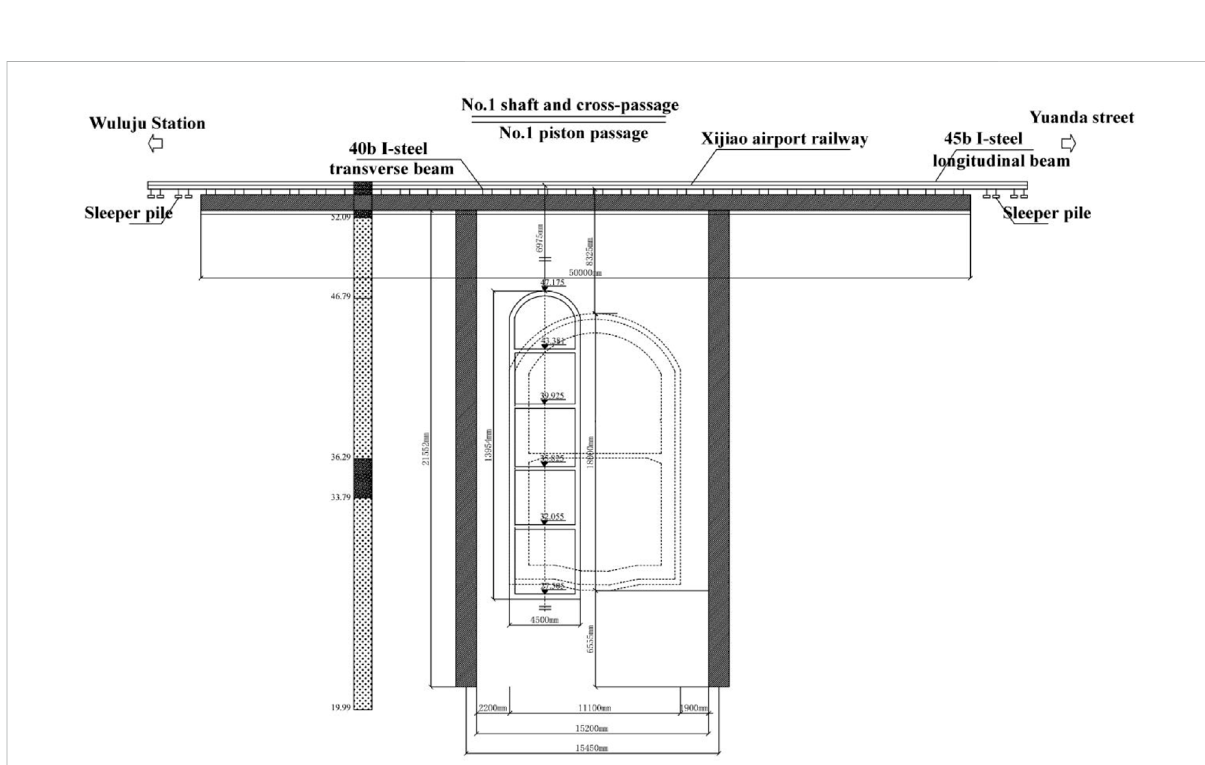
FIGURE 7 Rail reinforcement arrangement longitudinal section of No.1 passageway construction